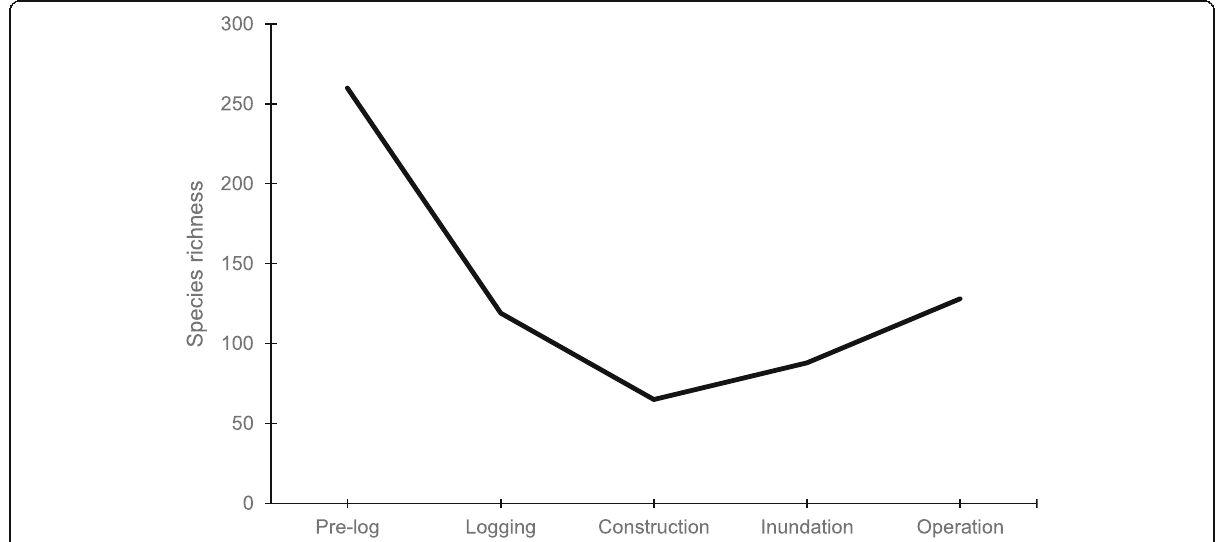
Fig. 2 The bird species richness plotted against dam development phases throughout 10 years study in Puah Lake Catchment, Hulu Terengganu, Peninsular Malaysia